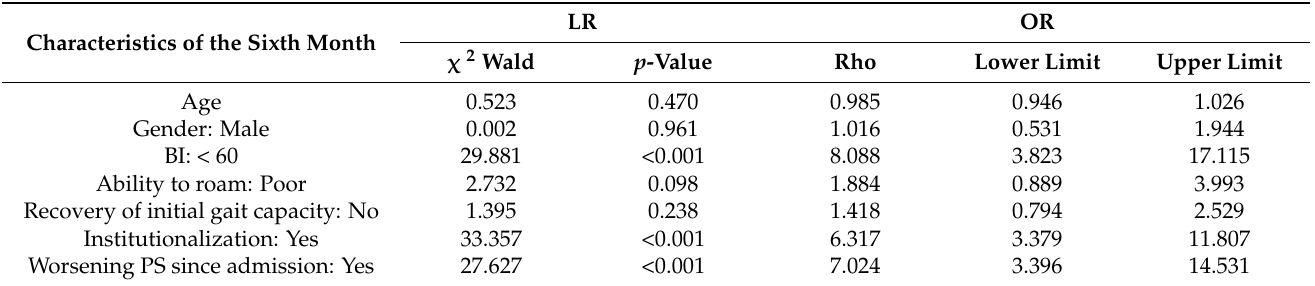
Table 6. Results of binary logistic regression to estimate the relationship between characteristics at the sixth month and their relationship with cognitive